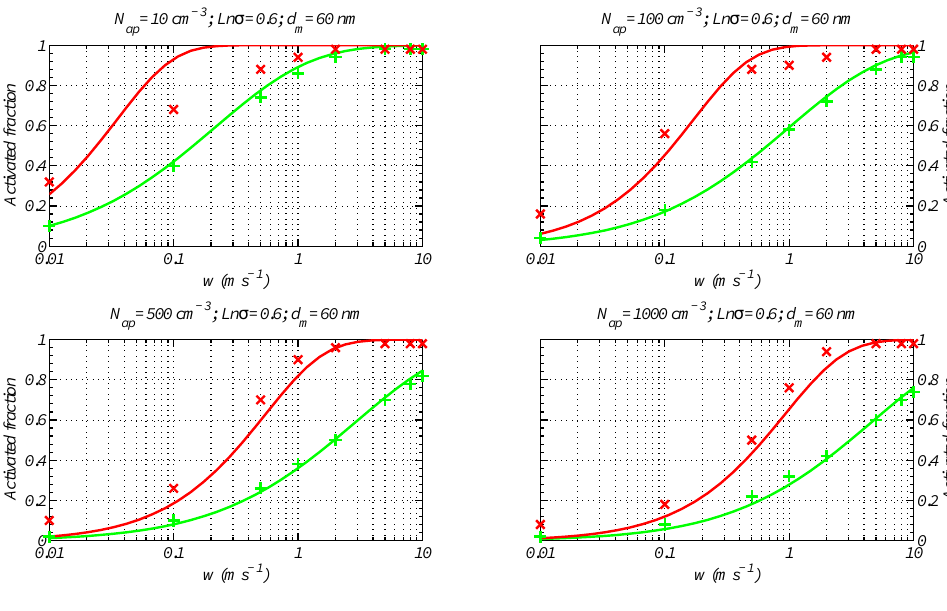
Fig. 8. Same as Figure 7 but for a broader distribution ( ln σ changed from 0 . 5 to 0 . 6 ). Fig. 8. Same as Fig. 7 but for a broader distribution (ln σ changed from 0 . 5 to 0 . 6).